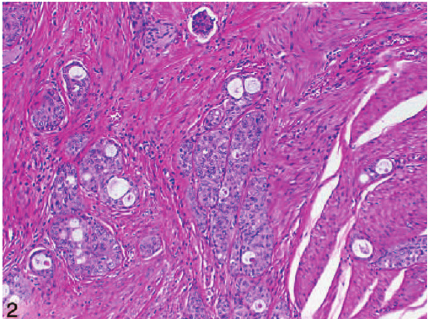
Figure 1: Low-power view showing closely packed, irregularly spaced, glandular, and cystic urothelial nests somewhat resembling von Brunn nests. Note that the overlying urothelium appears unin- volved (hematoxylin-eosin, original magnification × 100). Nested variant of urothelial carcinoma taken from Dhall et al. [2]. The figures have been reproduced with the permission of the editor in chief of Archives of Pathology and Laboratory Medicine on behalf of the editorial board of the journal.